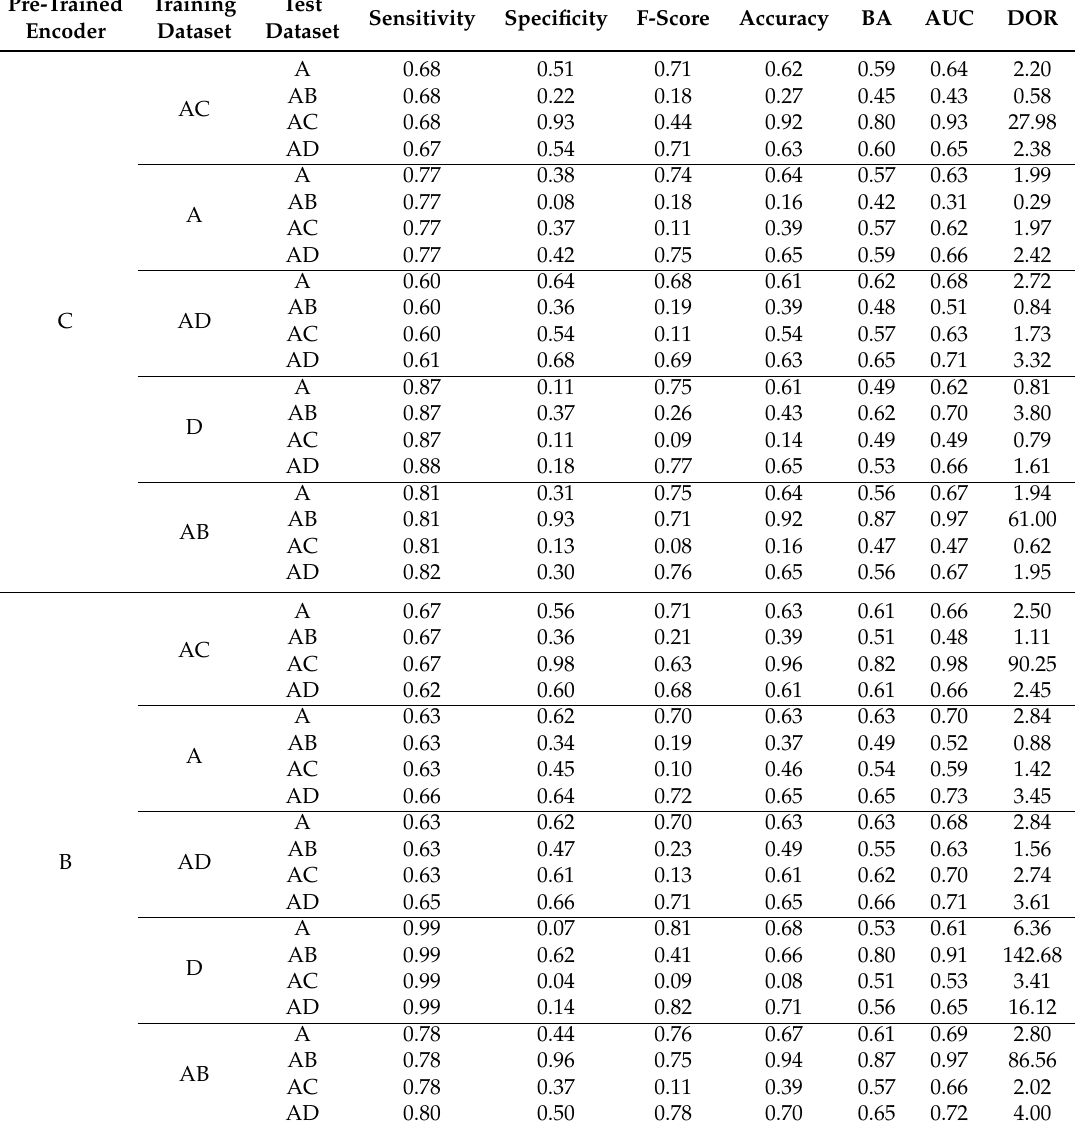
Table A4. Results obtained training a DenseNet-121 model. Dataset naming follows Table 1.